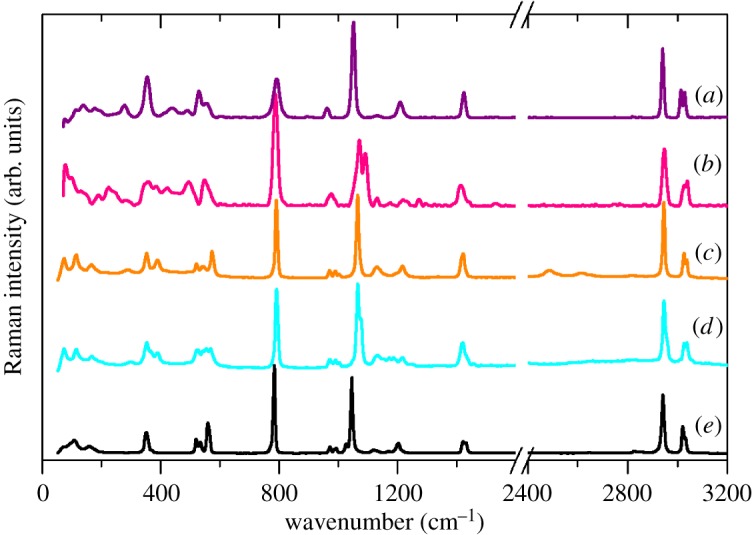
Raman spectra of: (a) Cu(H2O)4(CH3SO3)2, (b) Cu(D2O)4(CH3SO3)2, (c) Cd(H2O)2(CH3SO3)2, (d) Cd(D2O)2(CH3SO3)2 and (e) Ag(CH3SO3).